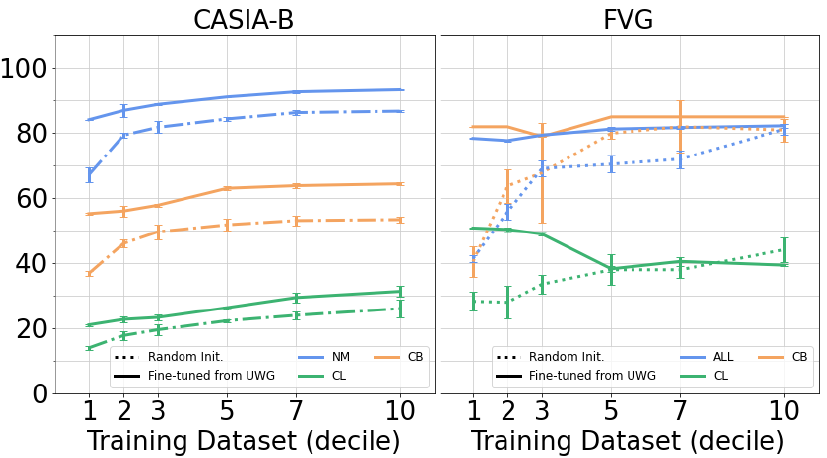
Figure 7. Performance of fine-tuning the proposed network on downstream evaluation benchmarks, with fractions of the training data. For FVG, runs are randomly sampled per subject. For CASIA-B, runs are randomly sampled uniformly from all angles per subject, and the average accuracy is across all viewpoints, where the gallery contains all angles except the probe angle. Pretraining on UWG results in a more stable training regime and significantly increased performance in scenarios with little labelled training data